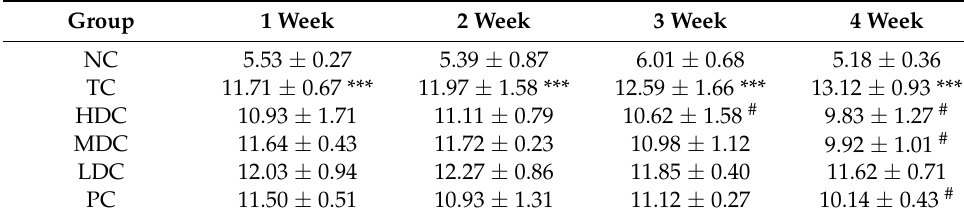
Table 1. Food intake of mice in each group (g/mouse/day).